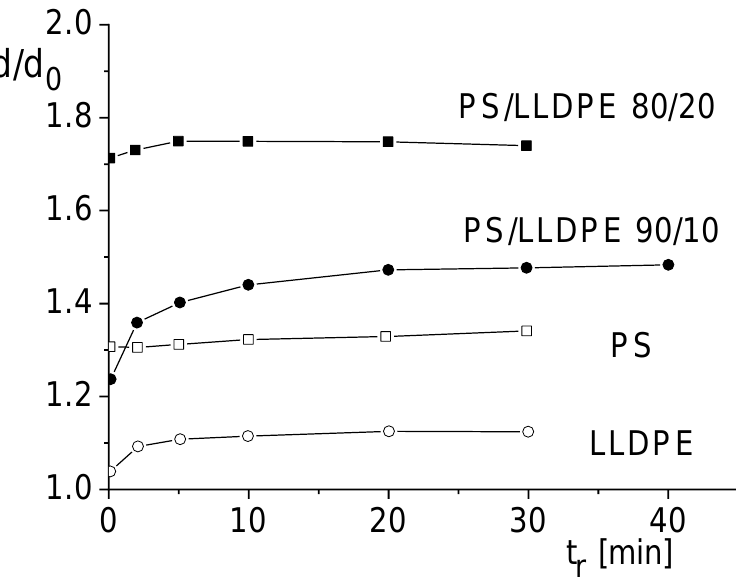
Figure 15. Extrudate swell d / d 0 as function of the annealing time t r in a silicone oil bath for two PS / LLDPE blends and their components. The diameter of the die was d 0 = 2.1 mm and its length to radius ratio L / R = 7.6. The shear stress at the wall was σ w = 40 kPa [29].